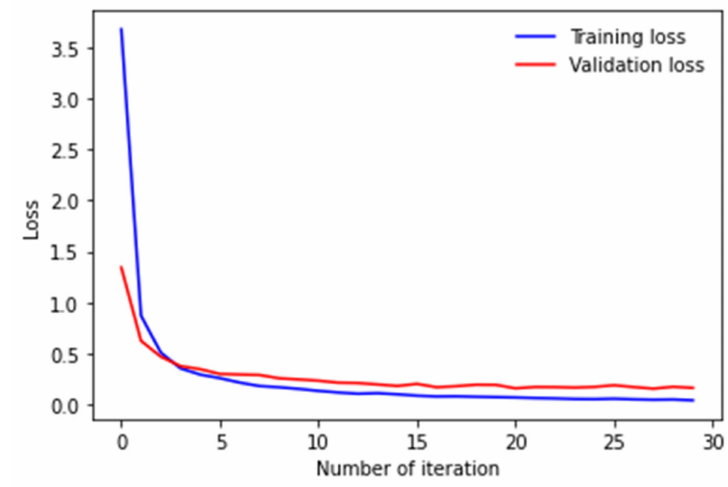
Figure 11. Training and validation learning curves on GoogLeNet.